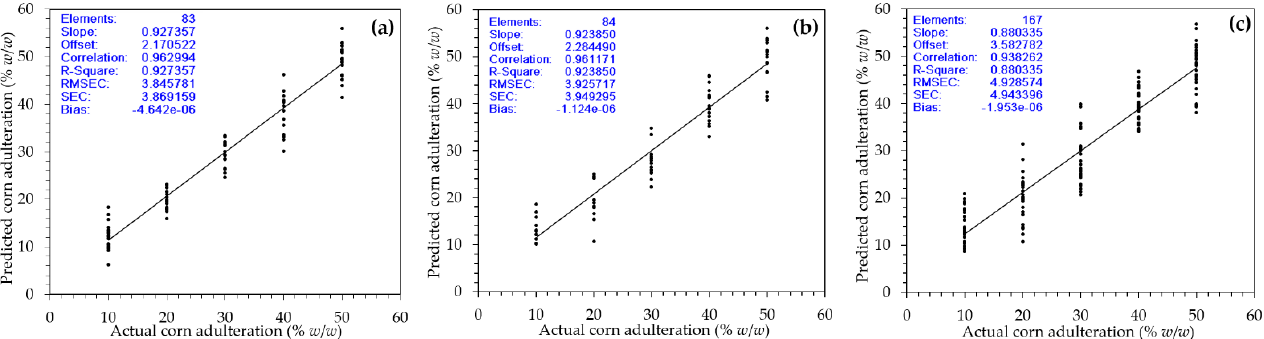
Figure 5. Actual versus predicted values of corn adulteration (% w / w ) in peaberry coffee samples for the best PLSR model on ( a ) individual wet calibration samples, ( b ) individual dry calibration samples, and ( c ) combined calibration samples.